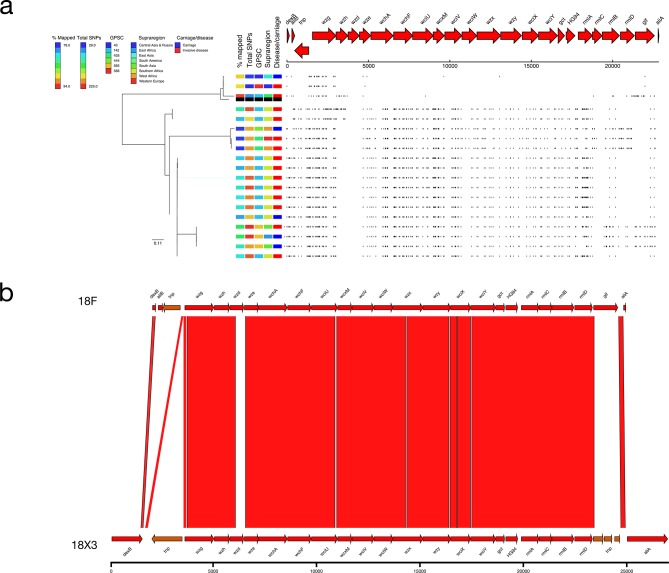
(a) Phylogeny and SNP map of serotype 18F. (b) Comparison of the putative serotype 18Xii sequence and the serotype 18F reference sequence.